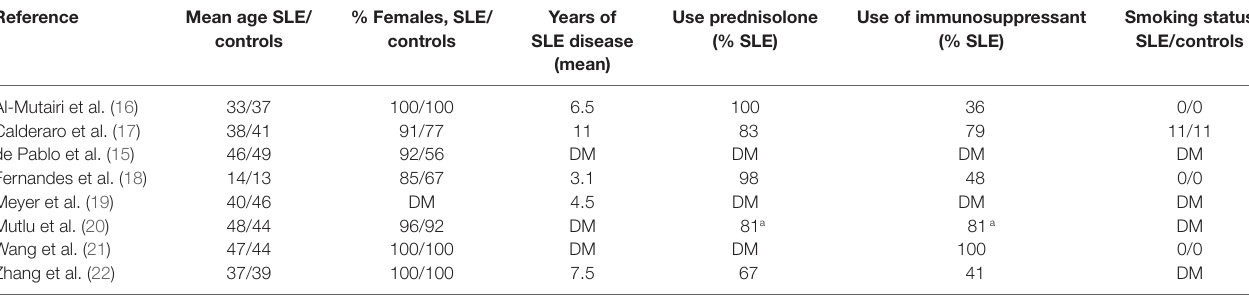
TaBle 3 | Demographic of